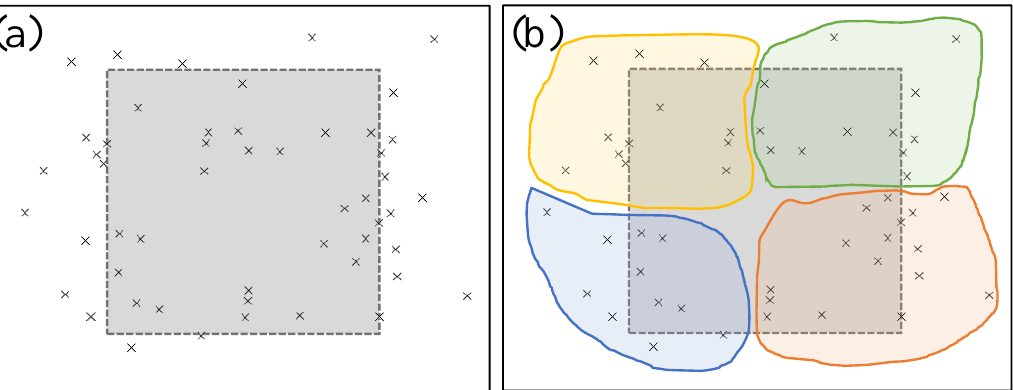
Figure 7. Human demonstrations and their clustered results. ( a ) Initial positions of the pegs (“x” symbols) with respect to the hole. The edge of the gray box indicates the boundary between the outside and inside of the hole. ( b ) Clustering results obtained by the k-means clustering algorithm using the reaction force/moment measured at the initial positions. We performed approximately 50 demonstrations to evaluate the clustering